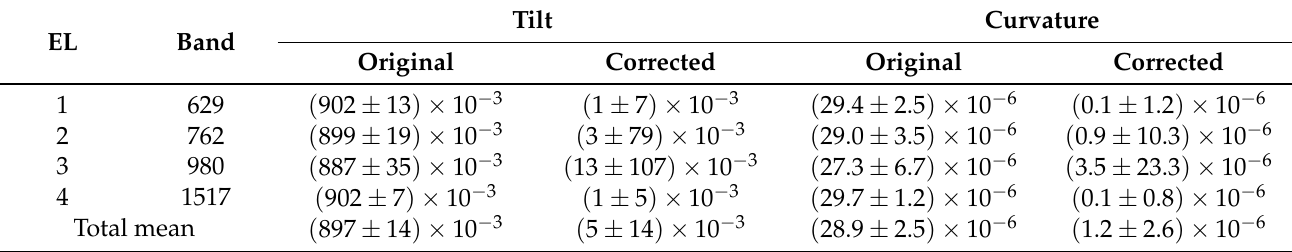
Table 1. Mean values of tilt and curvature of 937 synthetic frames. Frames were generated with 1 ◦ tilt and 3 × 10 − 5 1 / px curvature, which correlate well with mean values shown in original columns. Used error estimate is the standard deviation of the mean. Corrected values show that they are zero at the limit of the used metrics, as the error is greater than the values themselves. The four emission lines selected for the correction cover wavelengths approximately from 400 to 600